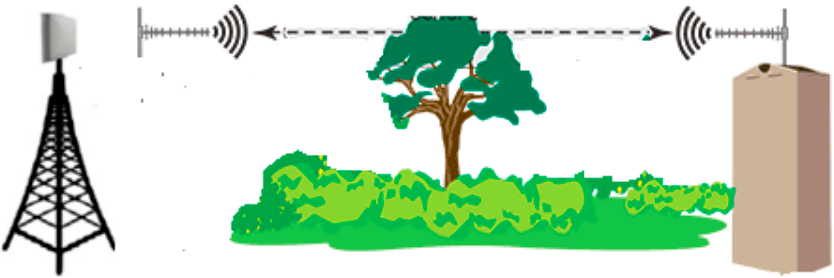
Figure 2. Visual representation of a non-line-of-sight (NLOS).